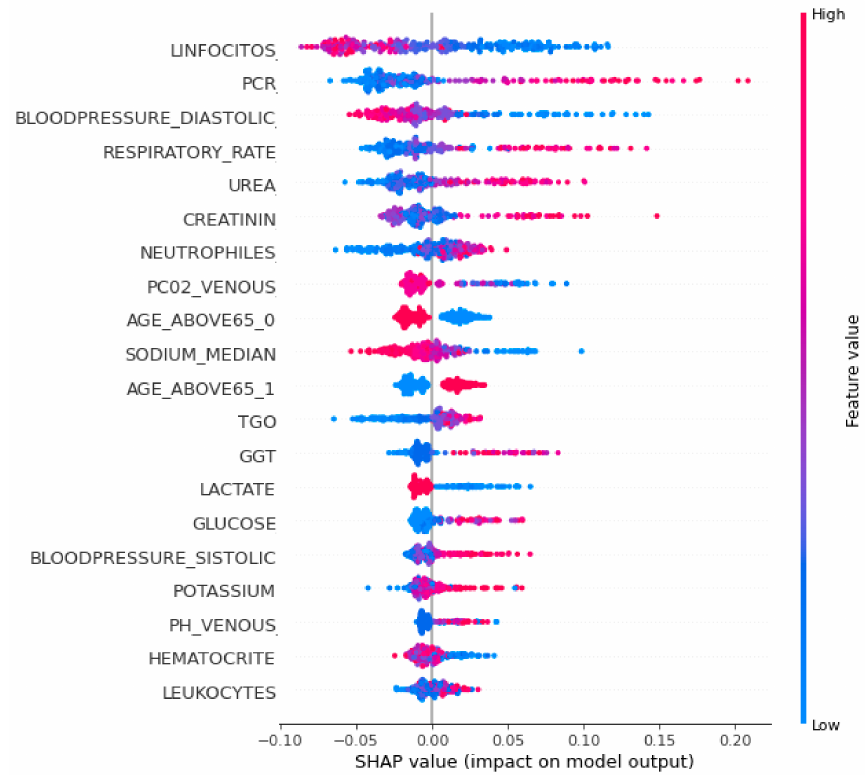
Figure 4. SHAP summary plot of the XGBoost